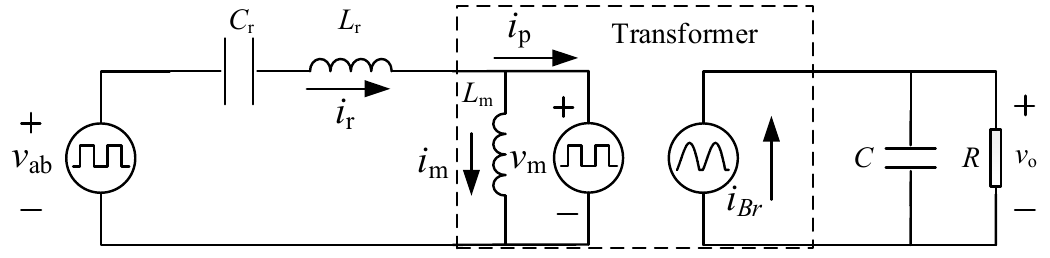
Figure 3. Equal circuit of LLC resonant converter.